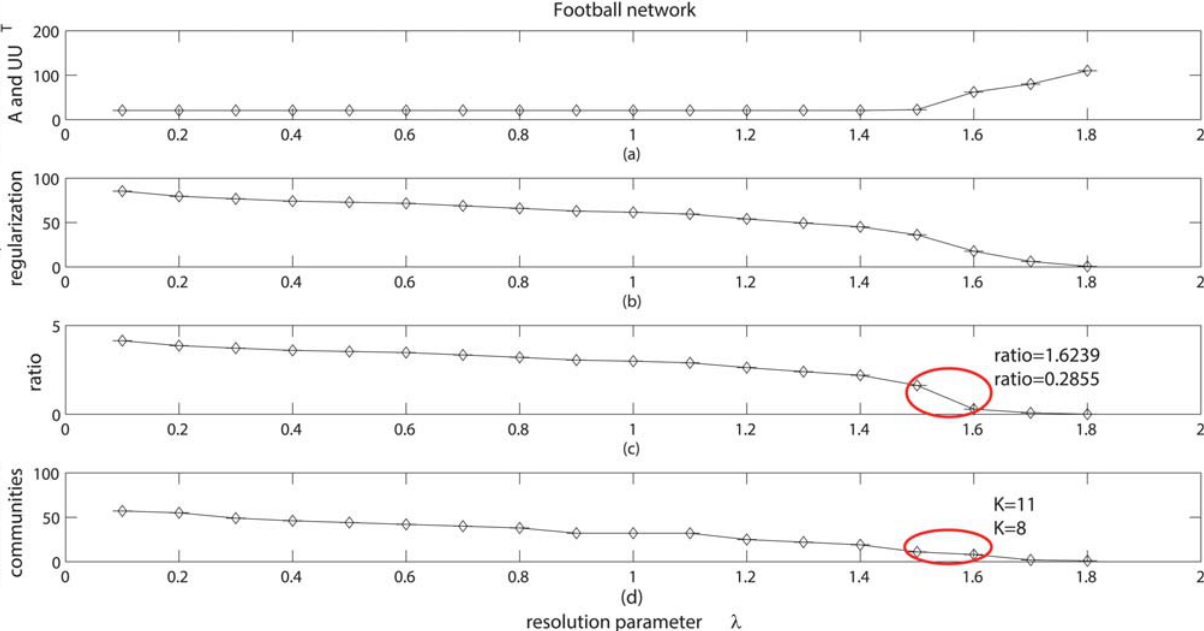
Fig 14. Resolution parameter analysis on football network. (a) shows the error between the adjacency matrix A and the expected adjacency matrix UU T